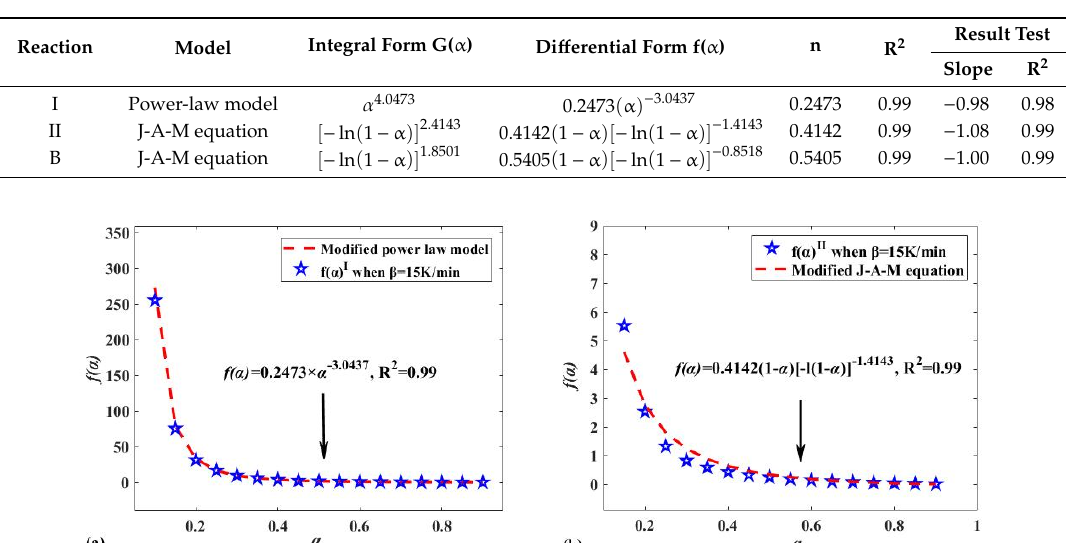
Table 5. Modified power-law model and the J-A-M equation.